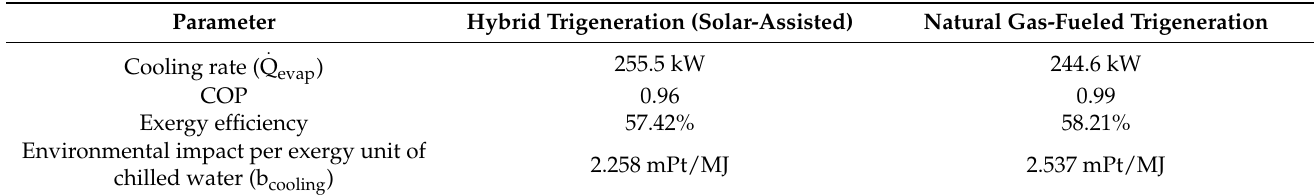
Table 7. Comparison between hybrid and non-renewable trigeneration (without solar field). Parameter